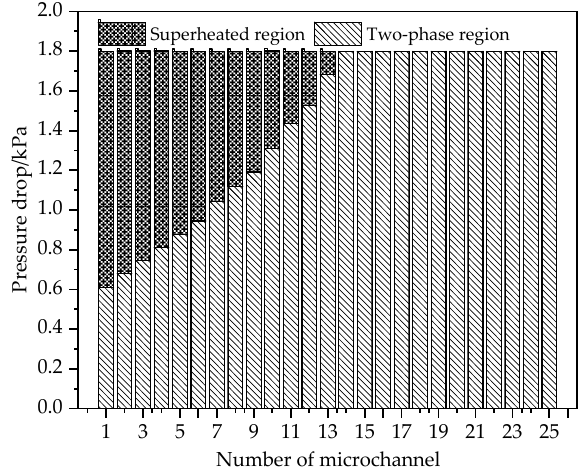
Figure 12. Pressure drop of the refrigerant in the microchannels.